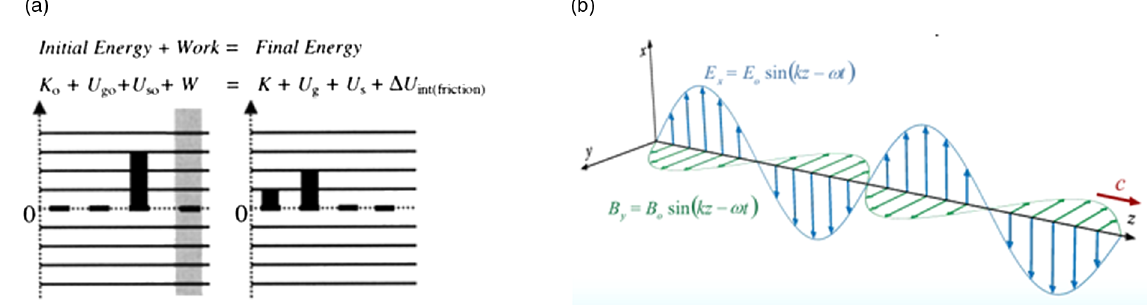
FIG. 1. Examples of visual representations used in physics teaching. (a) Example of an energy bar chart. Reproduced from Ref. [1]. (b) Example of conventional representation of electric and magnetic